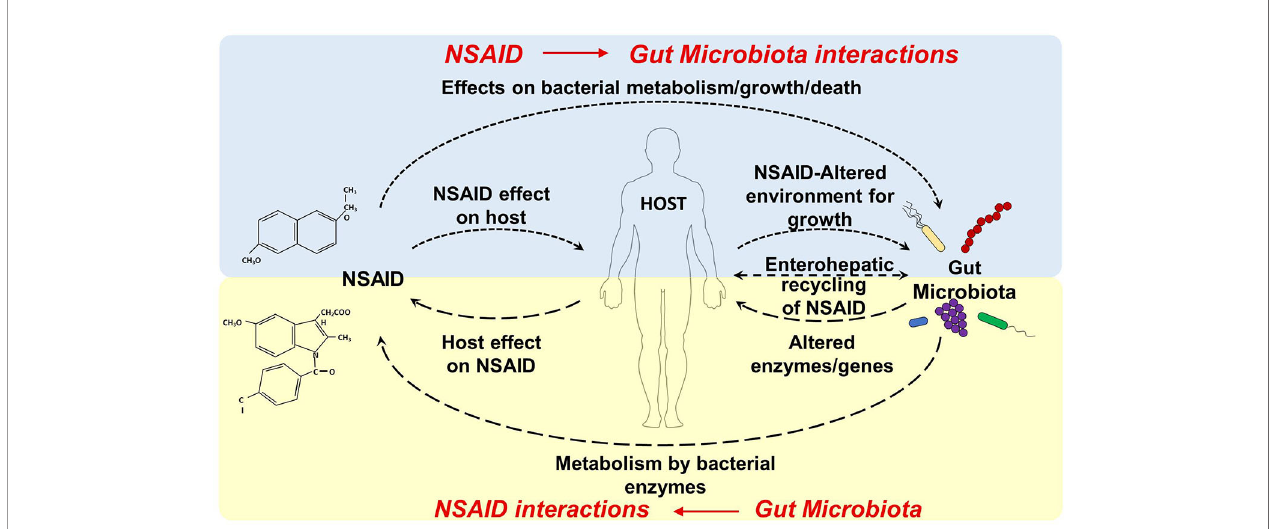
FIGURE 1 | Dynamic interactions between NSAID and gut microbiota. NSAID Direct effects: NSAIDs can have antibacterial properties that directly affect the composition of the gut microbiota (by effecting bacterial metabolism/growth, and/or inducing microbial cell death). NSAID Indirect effect: NSAIDs can alter the physiological properties or functions of host organs ( e.g. by changing the gut environment, changing mucosa integrity and permeability, and interfering with host and microbial metabolism) which may, in turn, precipitate in dysbiosis. Gut Microbiota Direct effects: the gut microbiota can directly biotransform orally and systemically administrated drugs into other chemical forms or metabolites, which may have altered ef fi cacy or toxicity. Gut Microbiota Indirect effects: the gut microbiota can indirectly impact the ef fi cacy and toxicity of drugs by altering the host metabolism capacity or processes (by in fl uencing hepatic function, altering expression of hepatic enzymes or metabolic genes, interfering with detox